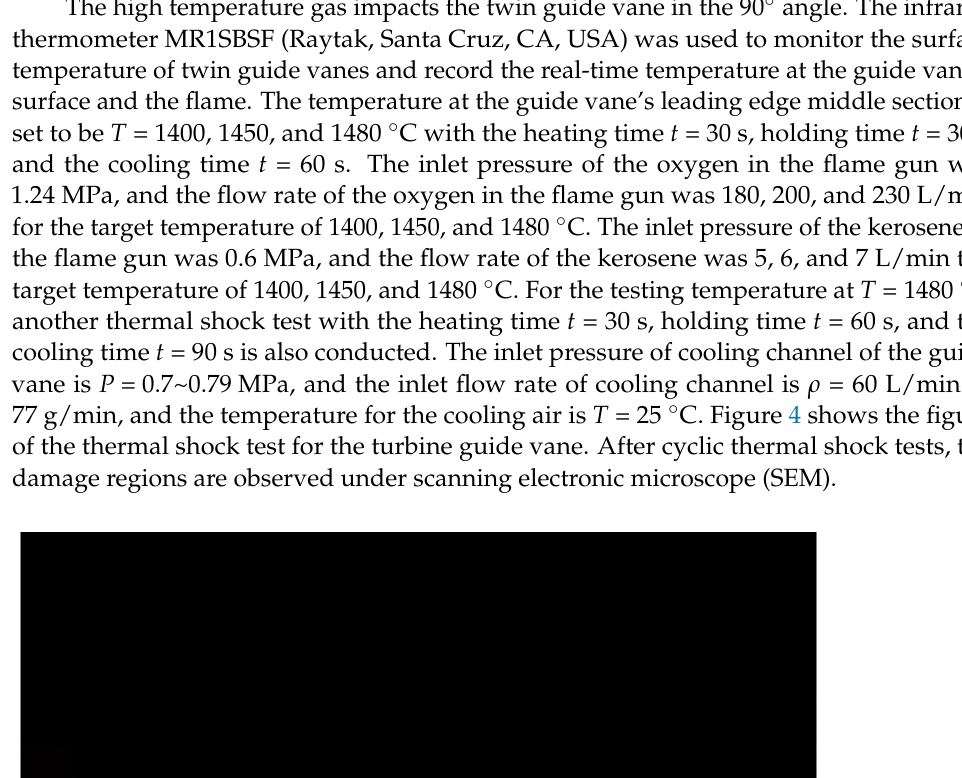
Figure 5. Surface temperature distribution for the twin guide vanes under thermal shock test at the target temperature of T = 1400 °C ( a ) Basin area of the left guide vane; and ( b ) Back area of the right guide vane.